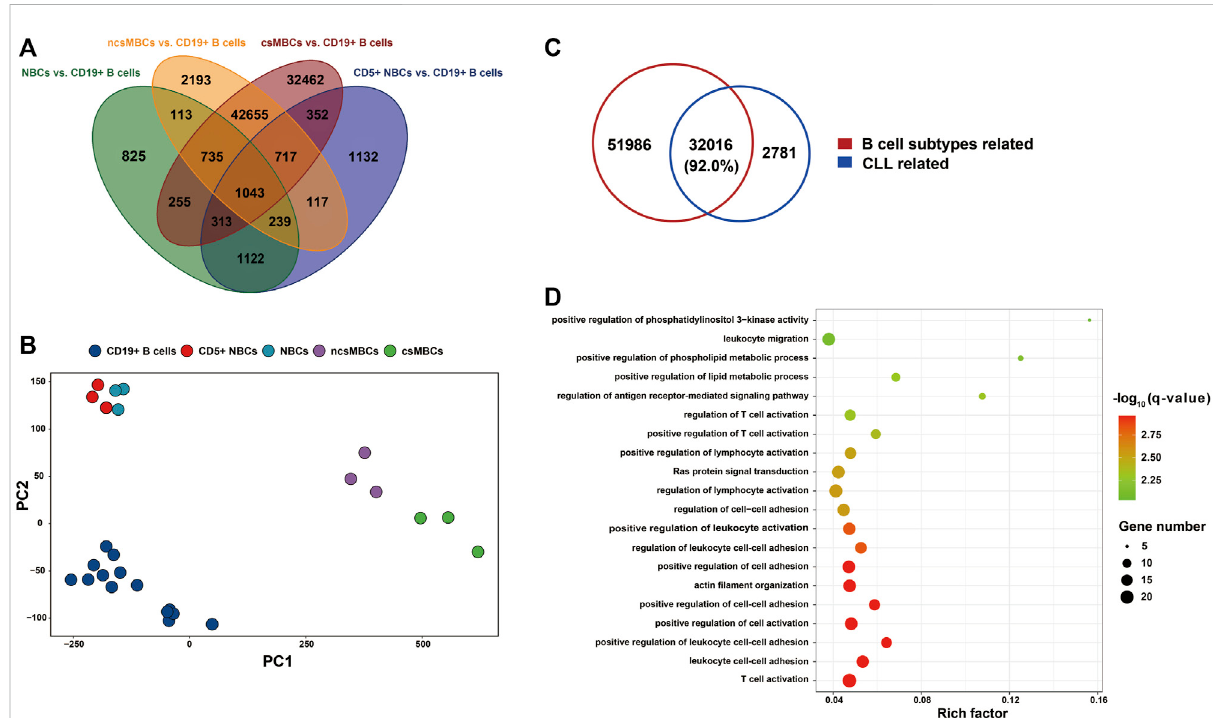
FIGURE 6 The implication of B Cell differentiation in CLL patients. (A) Petal diagram shown DMPs associated with B Cell differentiation (N = 84,273). The DMPs were identi fi ed by comparing each B Cell subtype ’ s DNA methylation with CD19 + B Cells mixture, using the dataset from Kulis et al., 2012. (B) PCA on the subtypes of normal B Cells based on M value of DMPs associated with B Cell differentiation (N = 84,273). ( C) CLL-related DMPs (N = 34,797)comparedtoDMPsassociatedwithBCellsubtypes(N=84,002). DMPsassociatedwithBCellsubtypes,notinthe406,879CpGsofthe whole genome were removed before integrating. (D) Bubble chart shown the top 20 biological processes using enrichment analysis of the DMEGs not associated with B Cell subtypes (N = 274). NBCs: naïve B Cells; CD5 + NBCs: CD5 + naïve B Cells; csMBC: class-switched memory B